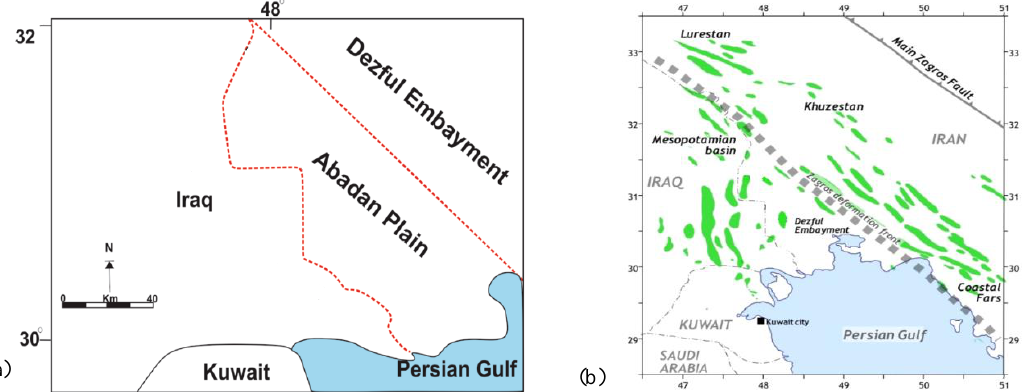
Figure 1. Location of Abadan Plain (a) and oil fields in SW Iran shown with green color (b) after [33, 34]